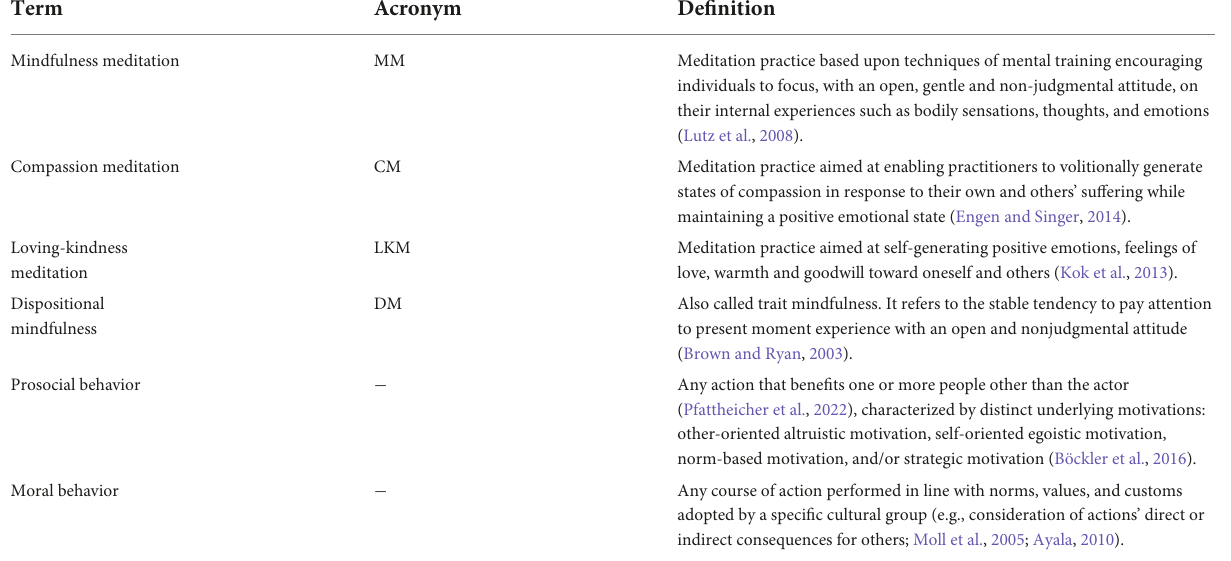
TABLE 1 Glossary: A summary table with the description of the acronyms and the definitions of the most important terms used in the perspective article. Term